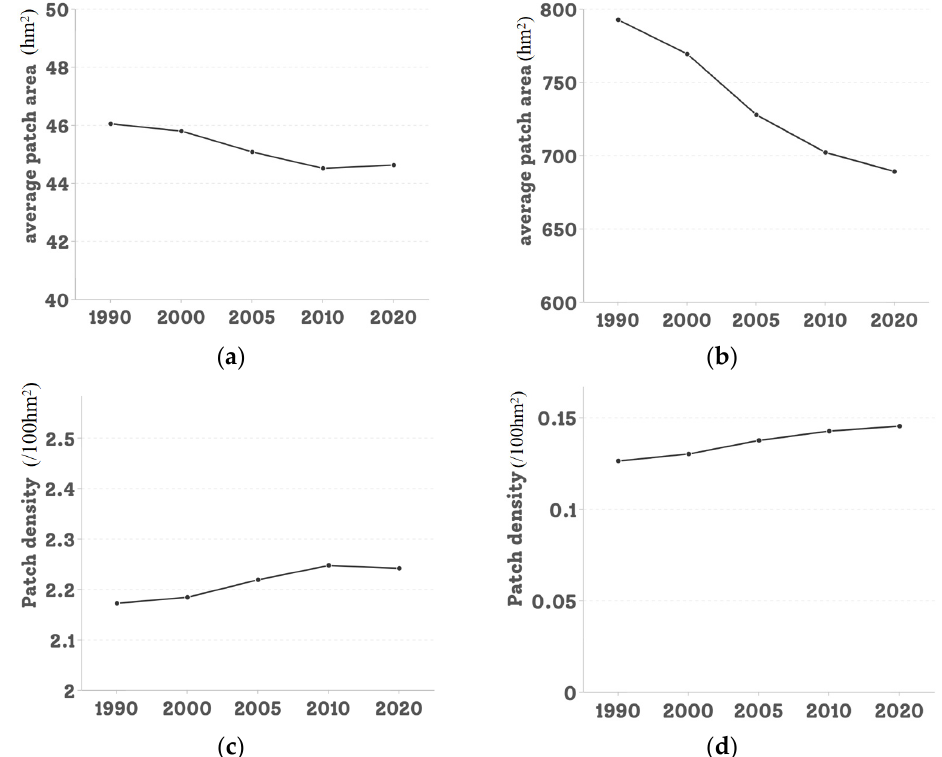
Figure 8. FVC outside the Greater Bay Area; ( a ) AREA_MN of grassland; ( b ) AREA_MN of forest; ( c ) PD of grassland; ( d ) PD of forest.